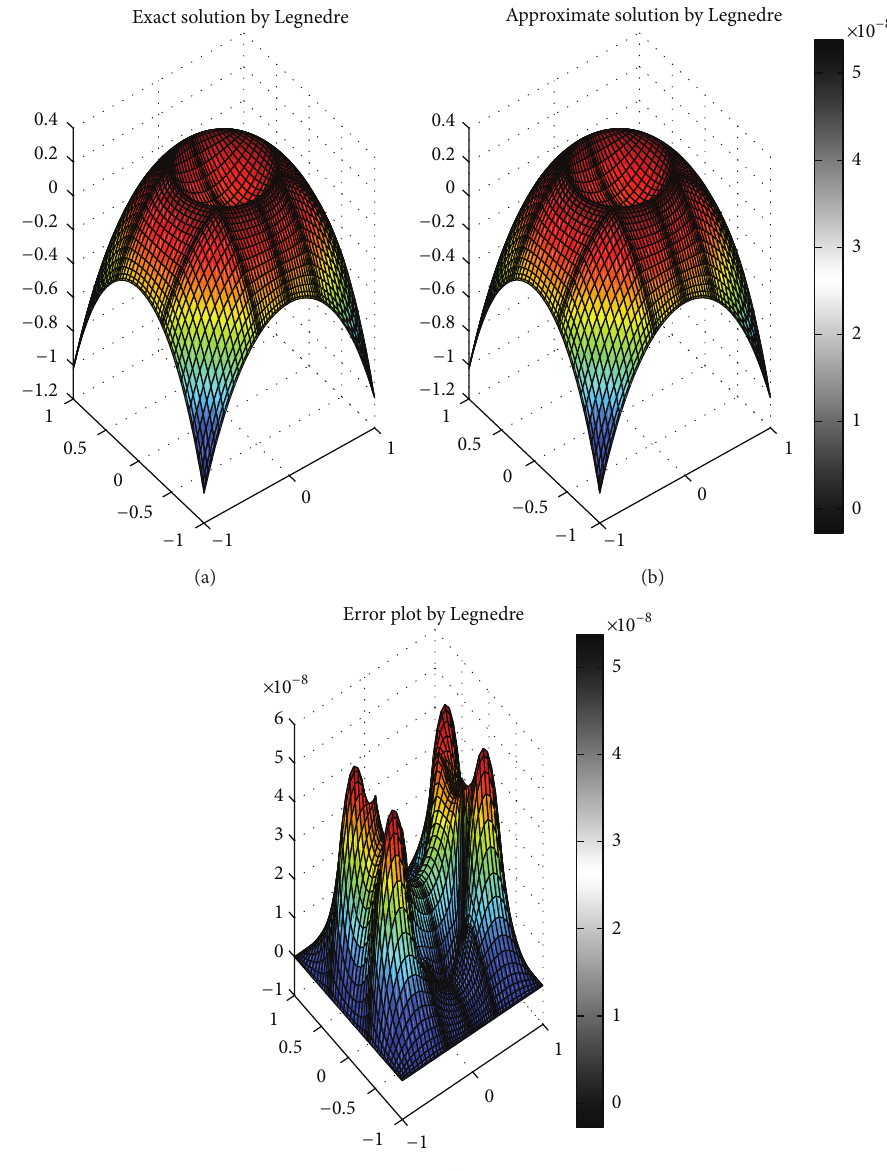
Figure 5: Exact solution, approximation solution, and its error for 𝐶 = 0.1 and 𝑏 = −3 .